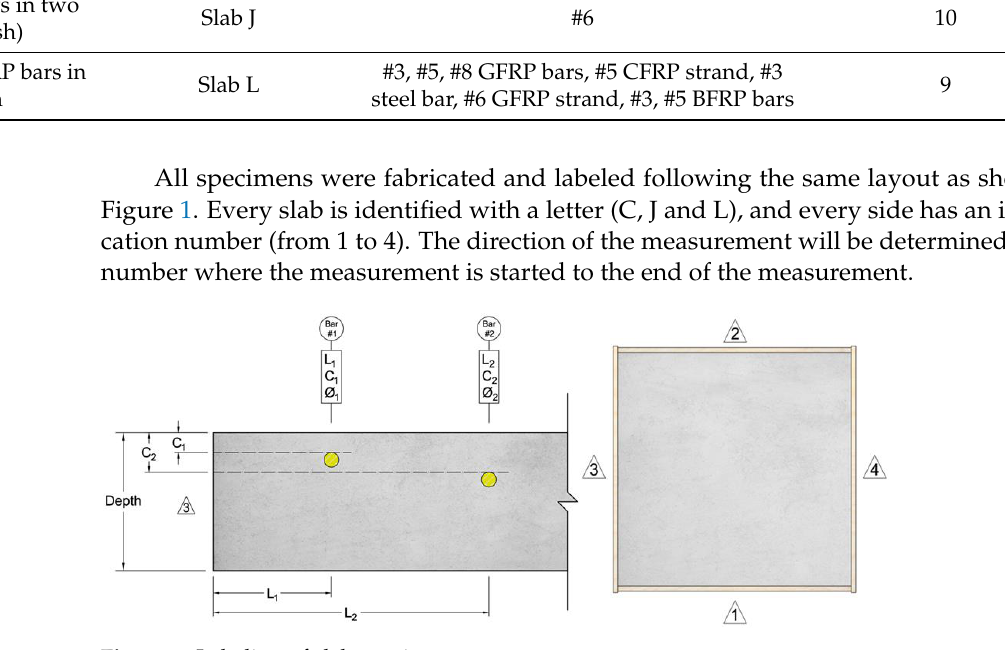
Figure 1. Labeling of slab specimens.